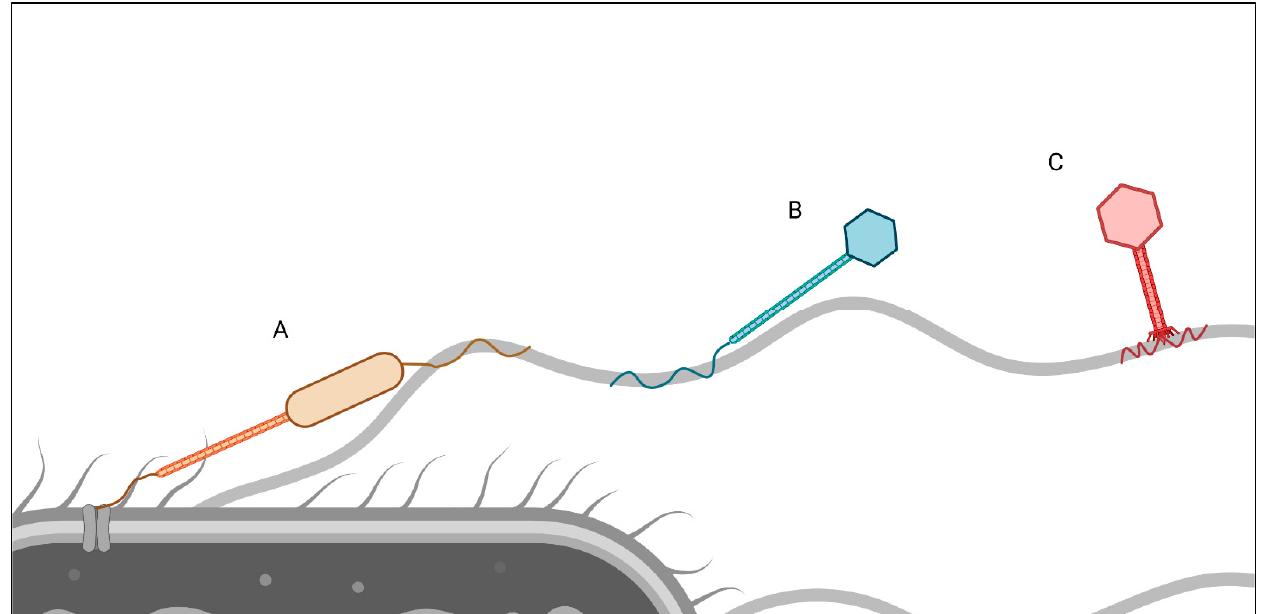
Figure 1. Flagellotropic bacteriophages and their diverse mechanisms of adsorption into bacterial flagella. (A) Φ CbK and its relatives attach to the Caulobacter crescentus flagellar filament via their head fibers and interact with their cell surface receptor using their tail and tail fiber [154]. These interactions may occur simultaneously. (B) Salmonella phage χ and its relatives attach to their host flagella with their single, long tail fiber [87,116,180]. (C) Bacillus phage PBS1 and its relatives use their multiple corkscrew-shaped tail fibers to attach to flagella [132]. Created with BioRender.com (accessed on 17 June